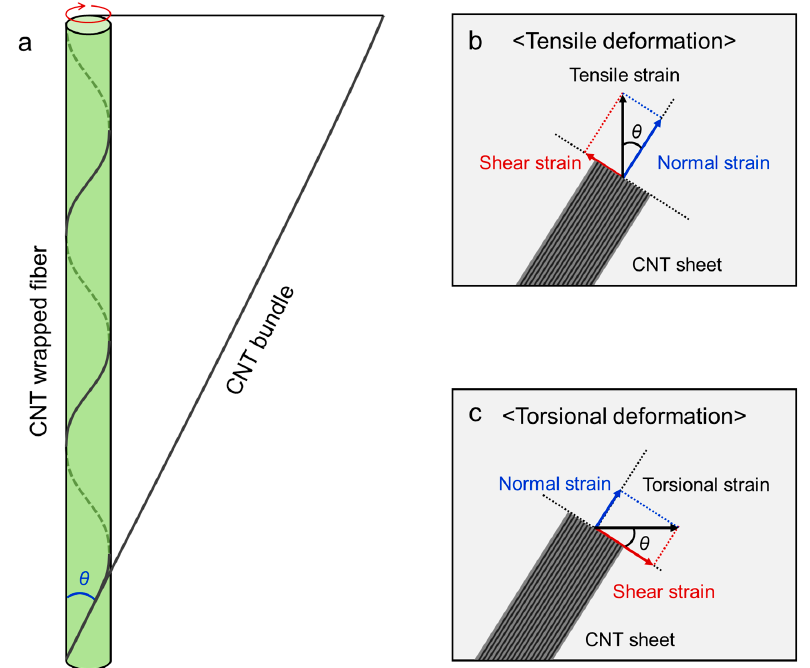
Figure 5. Tensile and torsional deformation sensing mechanism of CNT-wrapped core/sheath fiber strain sensor. ( a ) Schematic showing helical spring model for core/sheath CNT-wrapped fiber strain sensor with wrapping angle θ . Vector decomposition of ( b ) tensile and ( c ) torsional strain vectors applied to the CNT sheet with wrapping angle θ . Blue and red arrows indicate normal and shear strain vectors, respectively.